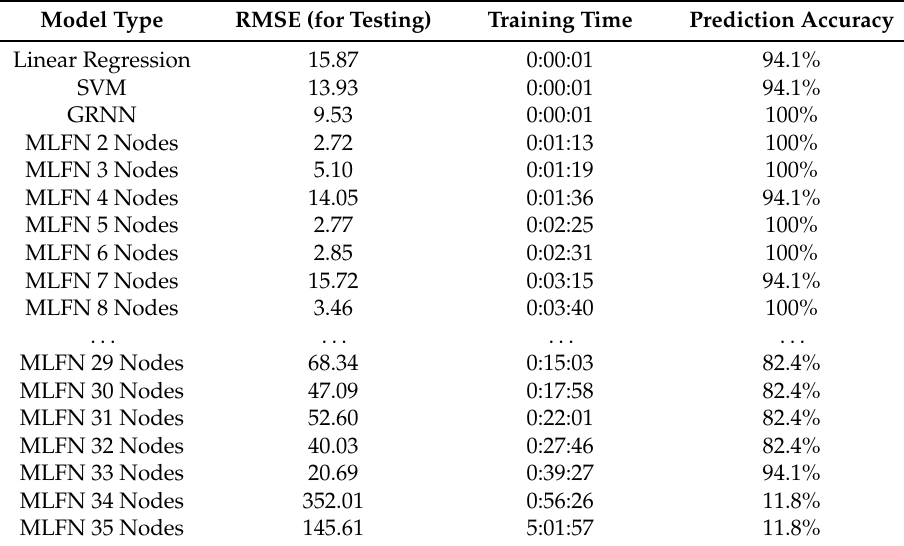
Table 3. Prediction models using experimental data by Klomfar et al.